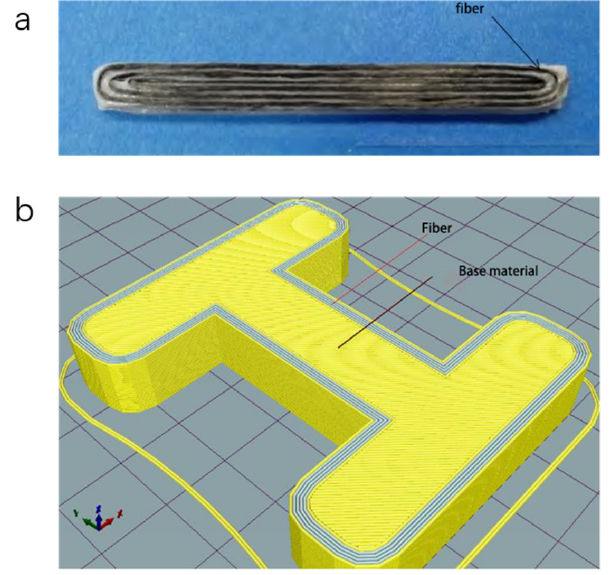
Figure 3. ( a ) Filling mode of the CFRF layer. ( b ) Contour offset filling method.